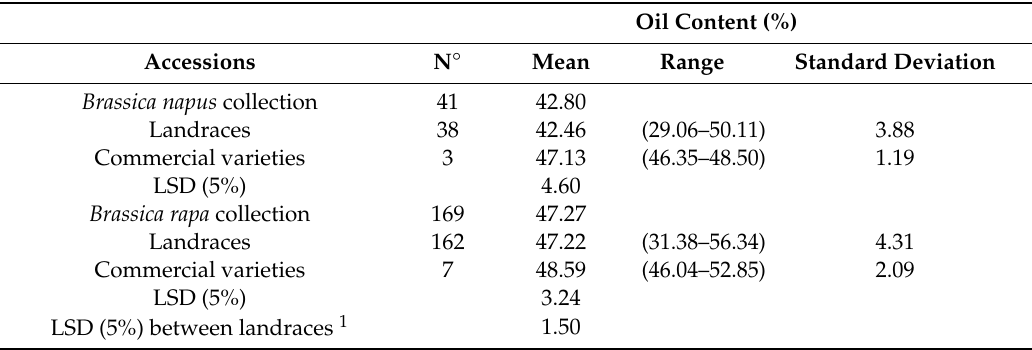
Table 1. Mean, range (minimum and maximum values), and standard deviation of oil content in the seeds of B. napus and B. rapa varieties from northwestern Spain.